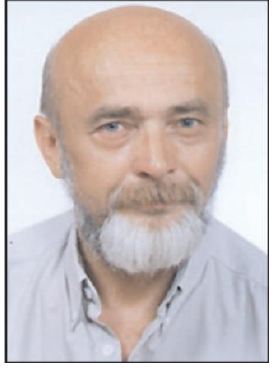
Figure 2. Dr. Nikola Šegudović.